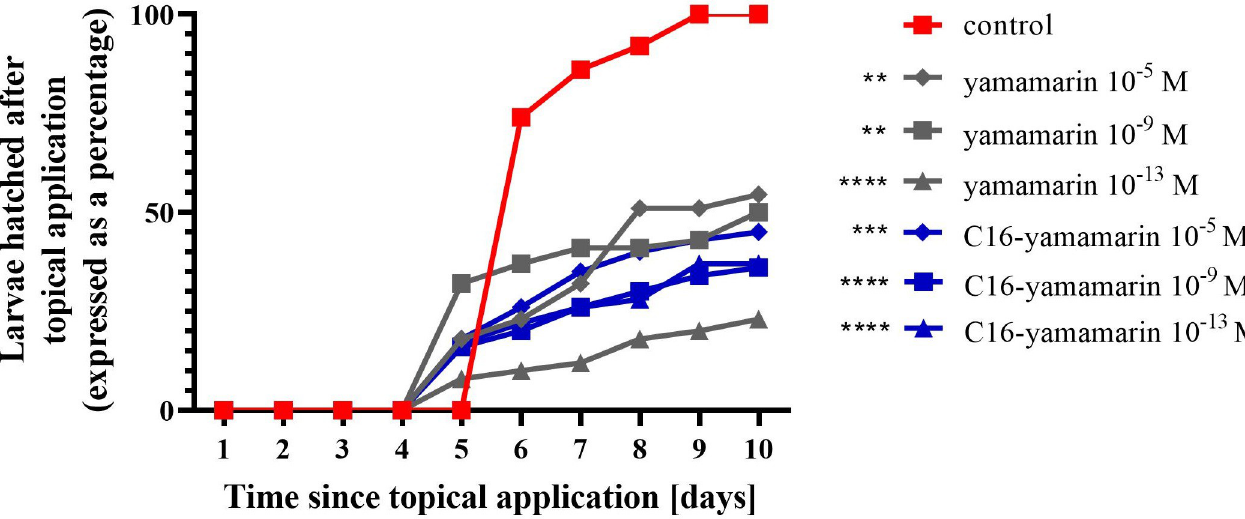
Fig 10. Duration of embryonic development and the hatchability of the next generation larvae from eggs, which were treated topically with physiological saline (control), yamamarin and C16-yamamarin. Statistically significant differences (two-way ANOVA with Dunnett’s multiple comparisons test) in comparison to the control are indicated by asterisks p � 0.01 ( �� ), p � 0.001 ( ��� ), p < 0,0001 ( ���� ).